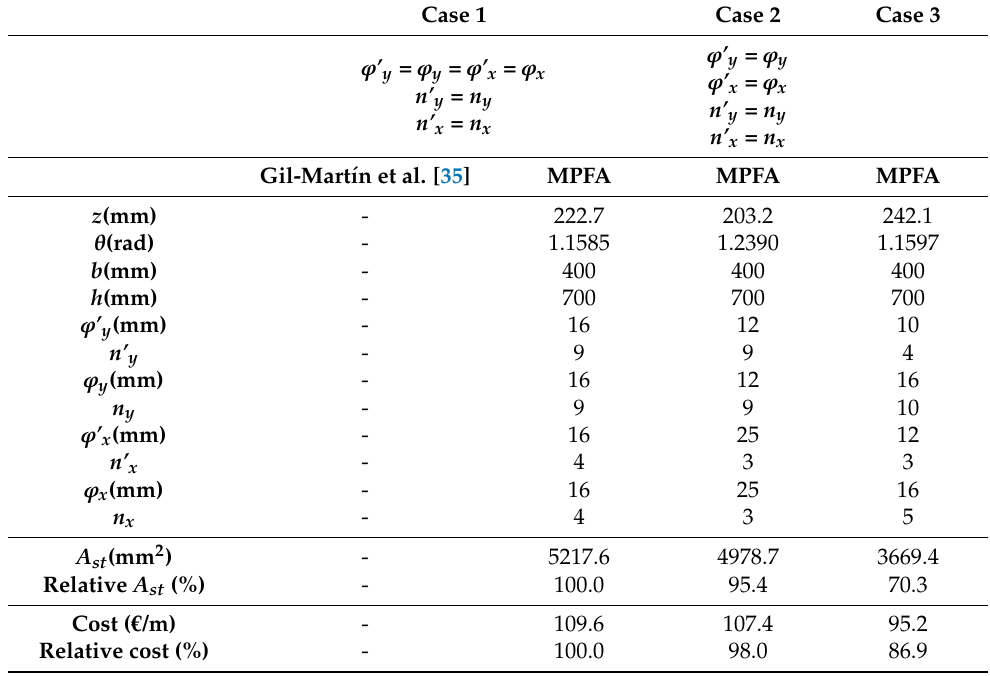
Table 7. Optimal design solutions with invariant section. ACI318.